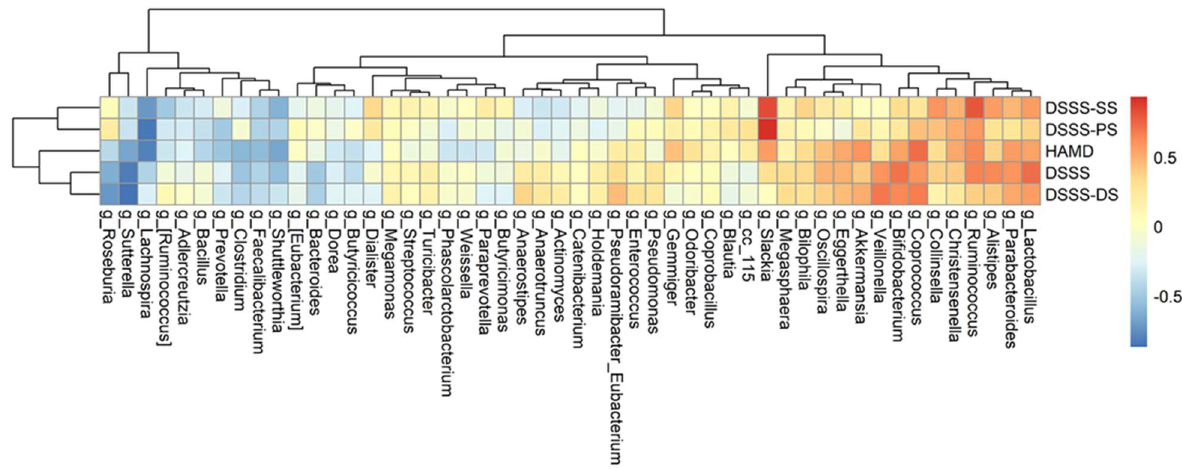
Figure 5. Correlation heatmaps between genera and the questionnaire scores. Fifty genera were detected in at least 50% of all 18 fecal samples. The differences in value of 50 genera and that of five biomarkers between two collection times were calculated first and then evaluated for their strength of correlation using Spearman’s correlation. Red denotes positive correlation, and blue denotes negative correlation. Column names of the heatmaps are the genera. The row names are the severity symptom measurements HAMD-17 and DSSS including the subscales of DSSS. Abbreviations: DSSS, Depression and Somatic symptoms Scale; HAMD-17, Hamilton Depression Rating Scale-17 items.